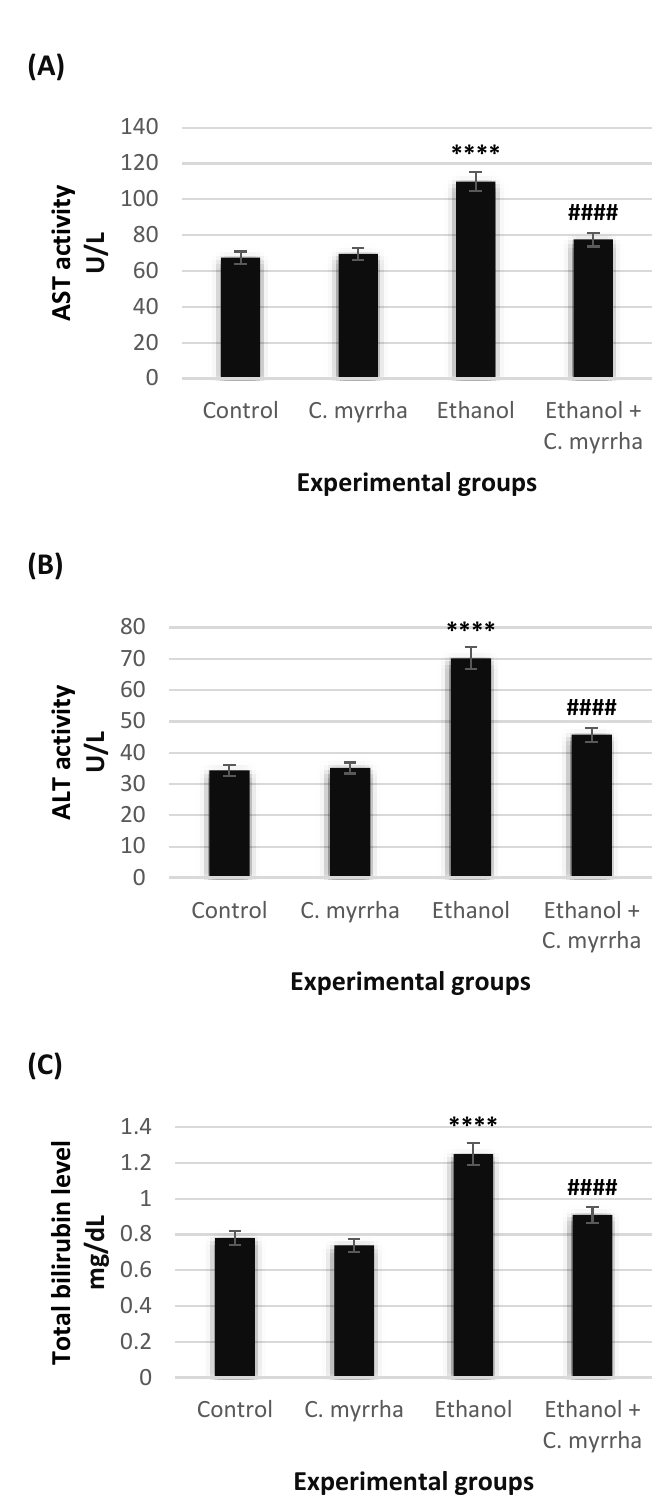
Figure 1. Effects of C. myrrha extract (500 mg/kg) and/or ethanol (40%, 3 g/kg) intake on the liver function parameters in serum after 30 days of treatment. ( A ) Aspartate transaminase (AST) activity expressed as units per liter (U/L). ( B ) Alanine transaminase (ALT) activity expressed as units per liter (U/L). ( C ) Total bilirubin level is expressed as milligrams per deciliter (mg/dL). All values are expressed as mean ± standard error (SE) of n = 7. **** p < 0.0001 vs. control; #### p < 0.0001 vs. ethanol-treated